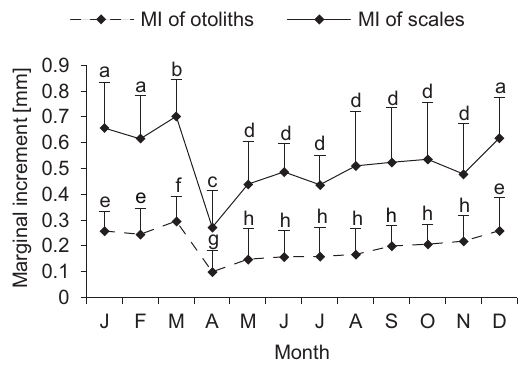
Fig. 2. Monthly evolution of the marginal increment (MI) of peacock wrasse, Symphodus tinca , from eastern coasts of Algeria; The different letters indicate signif- icant differences between sampling